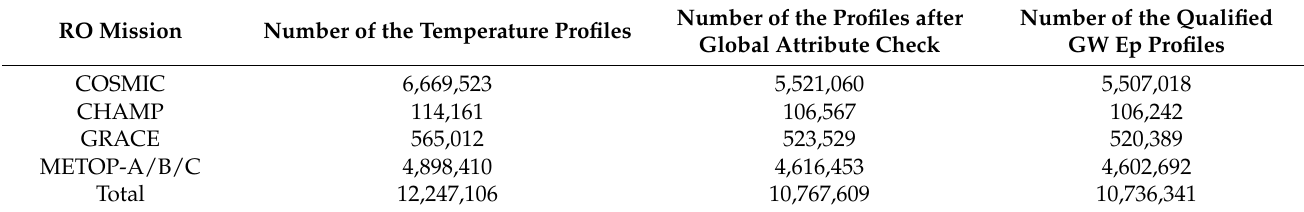
Table 1. The statistics on the numbers of the original RO temperature profiles and the numbers of qualified GW Ep profiles. RO Mission